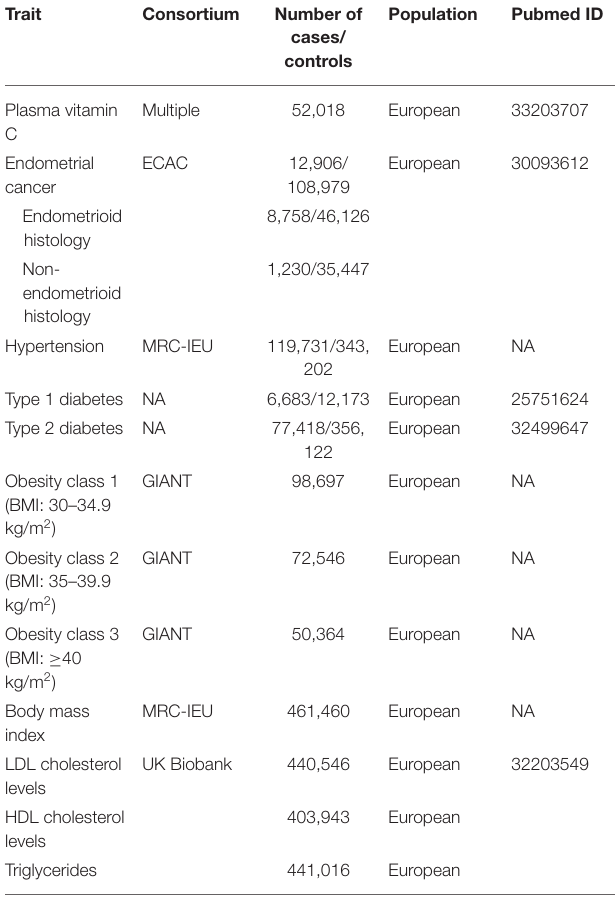
TABLE 1 | Details of traits used in Mendelian randomization